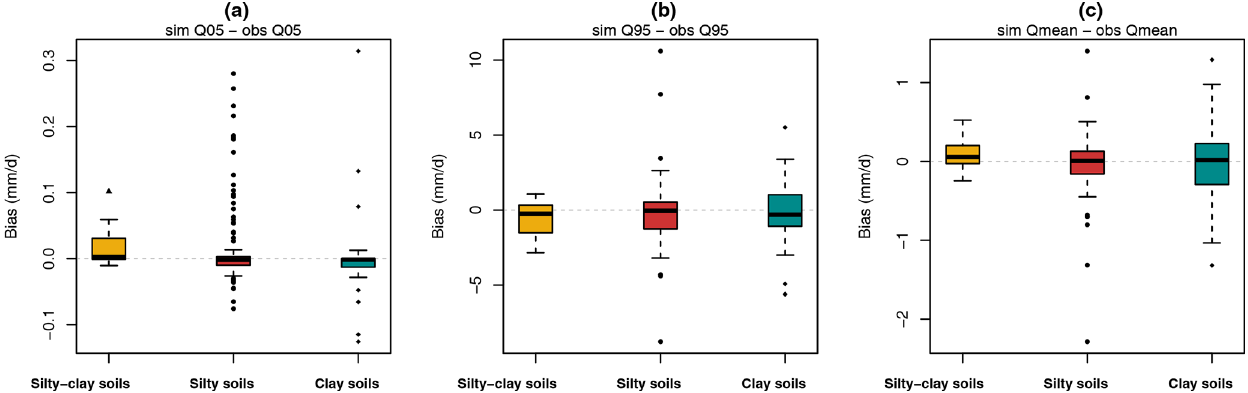
Figure 7. Differences between prediction and observation of low ( Q 05), high ( Q 95), and average ( Q mean ) flows. Each hydrological year from each site has been independently considered. Results are compiled by soil texture as follows: 142 points for silty soils, 17 for silty–clay soils, and 44 for clayey soils.